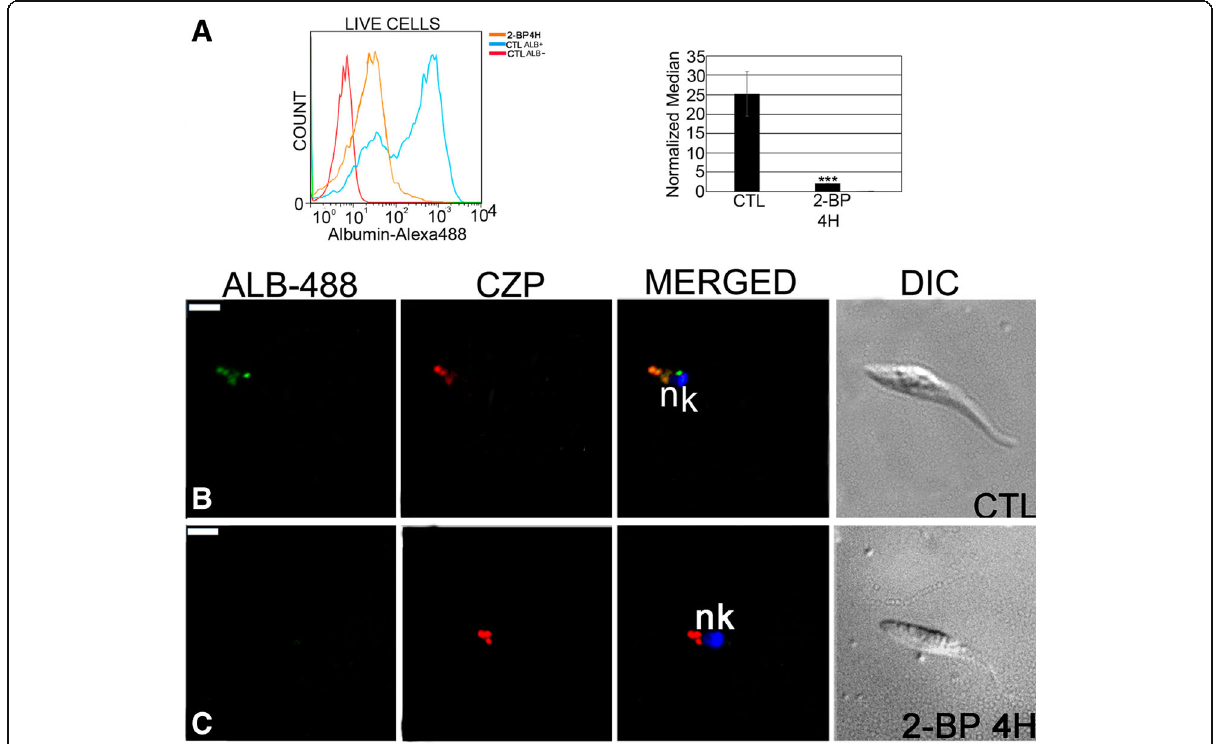
Fig. 6 Albumin-Alexa 488 endocytosis is altered in Trypanosoma cruzi epimastigotes by 2-BP treatment. a Flow cytometry analysis showing that albumin internalization was inhibited after treatment for 4 h with 2-BP. ***: p < 0.001. b Control: Co-localization of internalized albumin (ALB-488) with cruzipain (CZP) in reservosomes by fluorescence microscopy. c Parasites treated for 4 h with 2-BP showing no fluorescence signal of albumin (no co-localization with cruzipain). N: nucleus; k: kinetoplast. Bars = 5 μ